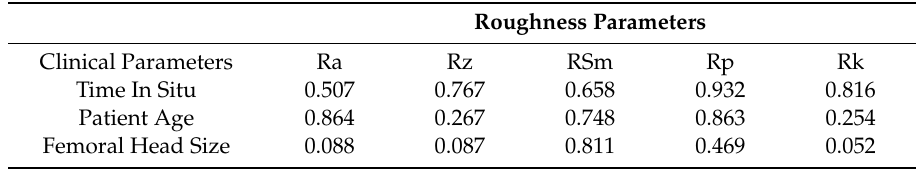
Table 7. Calculated p values for statistical correlations between roughness parameters and clinical parameters in the spacer group. Statistical significance is assumed for p < 0.05 and was not